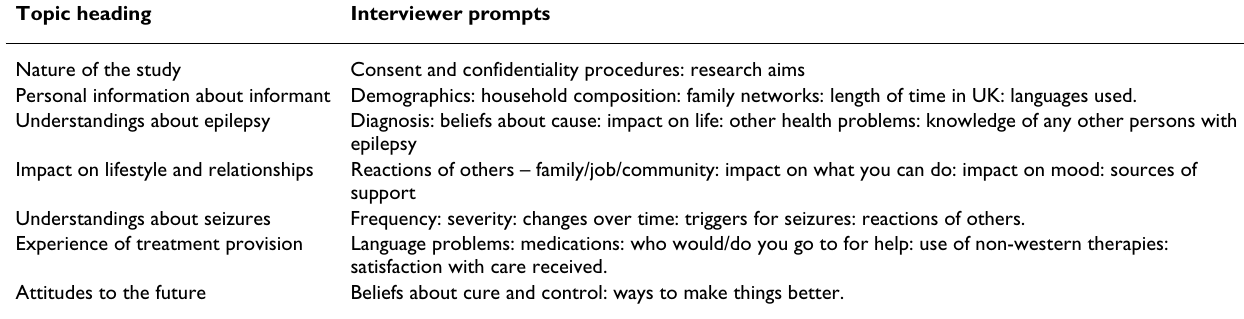
Table 4: Summary of the Interview Topic Guide Topic heading Interviewer prompts Nature of the